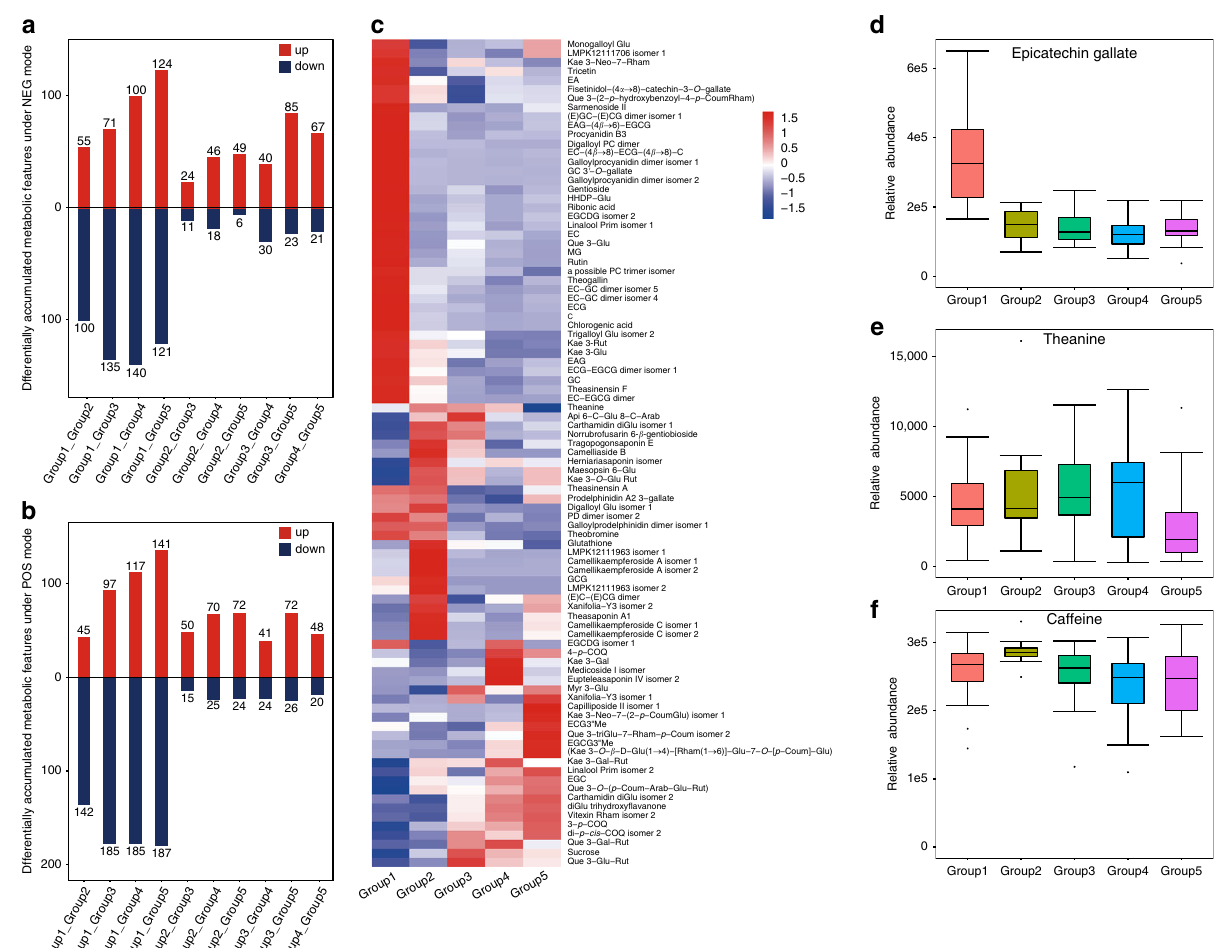
Fig. 4 Metabolites that showed signi fi cant changes in concentration in pairwise comparisons of fi ve groups of tea accessions. a , b Number of metabolic features that were detected under NEG ( a ) and POS ( b ) modes, respectively, and were identi fi ed as differentially accumulated in pairwise comparisons of fi ve groups of tea accessions. Red and blue bars indicate the numbers of metabolic features showing increase and decrease in concentrations, respectively. c Heatmap showing the abundance patterns of annotated metabolites with an average relative abundance greater than 500 in at least one tea group and with signi fi cant changes in abundance in at least one comparison. d – f Box plots of abundance of epicatechin gallate, theanine and caffeine in different tea groups. ( n = 29 for Group 1, 11 for Group 2, 32 for Group 3, 26 for Group 4, and 36 for Group 5). Boxes = interquartile ranges, middles = medians, whiskers = 1.5 × the interquartile range, single points = outliers. Source data underlying c – e , and f are provided as a Source Data fi